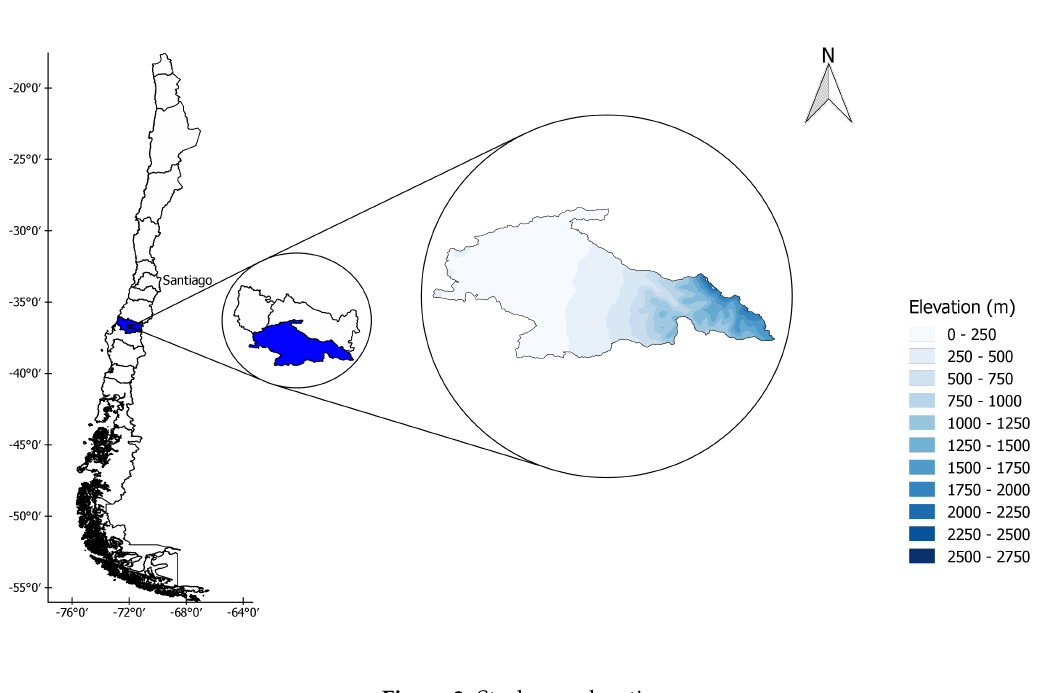
Figure 3. Study area